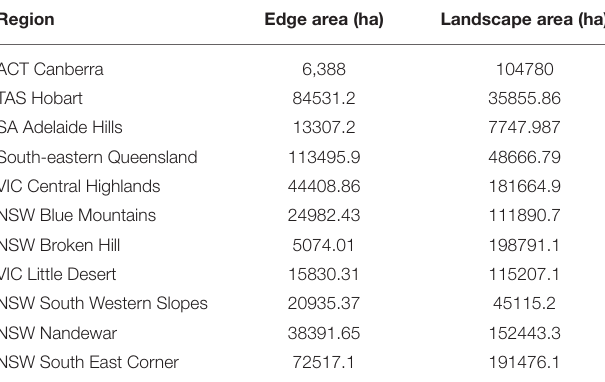
TABLE 2 | Area available for edge and landscape treatments in each case study landscape.